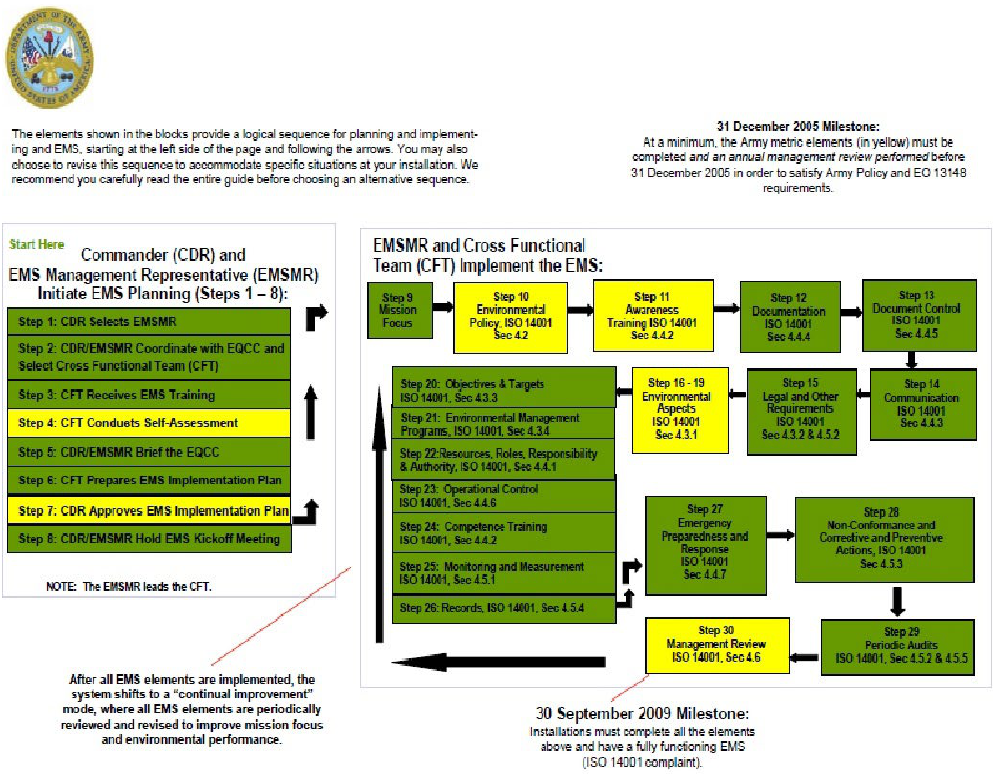
Fig. 6: US Army EMS implementation steps (Source: US Army-Environmental Center, 2005)